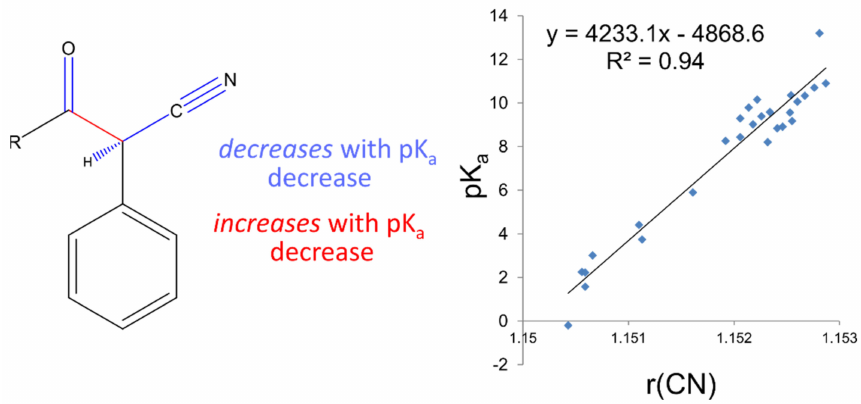
Figure 4. Modelling the nitrile-containing